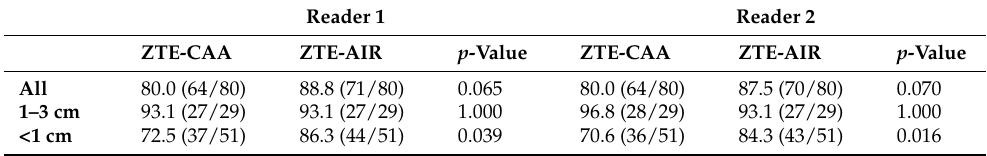
Table 5. Comparison of sensitivity on nodule-wise evaluation between ZTE-CAA and